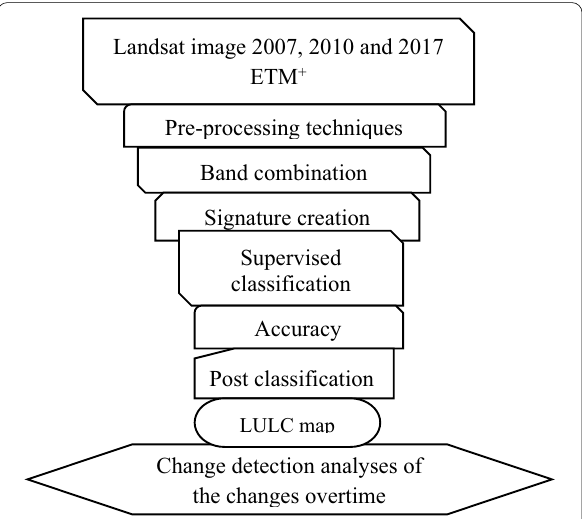
Fig. 2 Flow chart of satellite image analysis and Land use/land cover classification (Gidey et al. 2017)